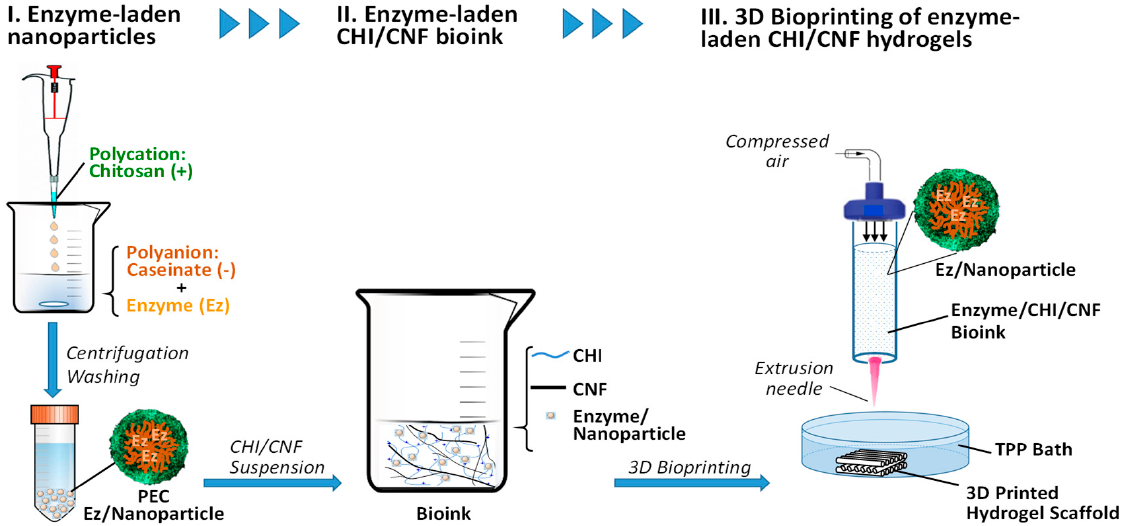
Figure 3. Schematic representation of the processing of enzyme-laden CHI/CNF hydrogel scaffolds by 3D printing of CHI/CNF bioinks containing enzyme (Ez) entrapped polyelectrolyte complex (PEC) nanoparticles.